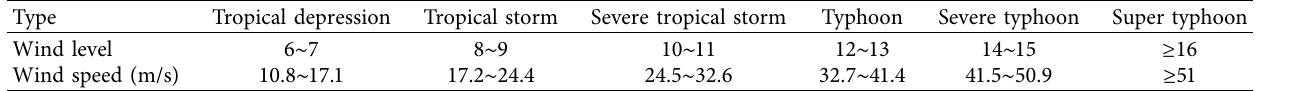
Table 1: Typhoon scale.